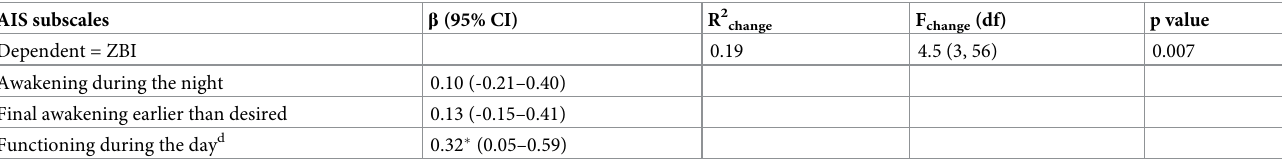
Table 5. Multiple regression analyses examining Athens Insomnia Scale predictors of Zarit Burden Interview score. (n = 60). AIS